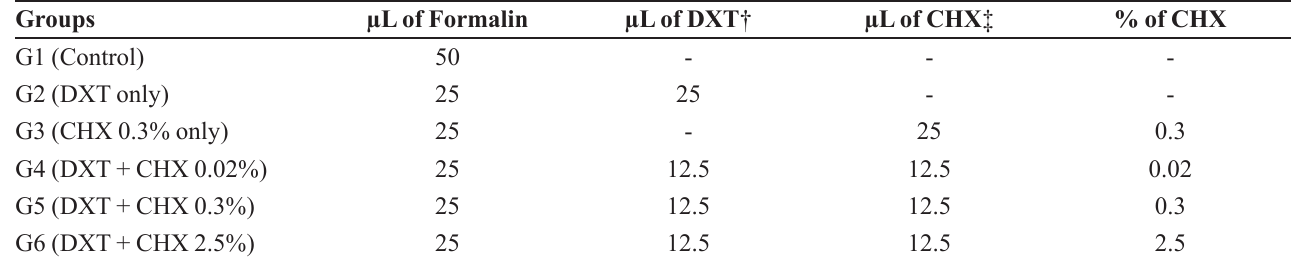
TABLE I - Description of the experimental groups